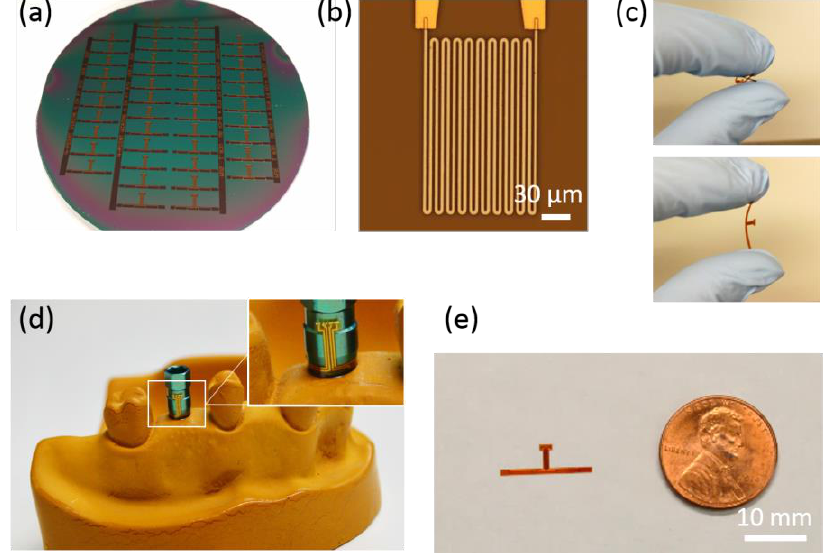
Figure 4. Microfabricated temperature sensors. ( a ) A total of 46 sensors on a silicon wafer before releasing. ( b ) Bright-field microscopic image of one channel of Pt resistor and overlapped Au interconnection lines before covered by top insulation layer. ( c ) Highly flexible sensor without mechanical damage. ( d ) Adhered temperature sensor around an abutment wing of the dental implant platform. ( e ) Developed temperature sensor smaller than a